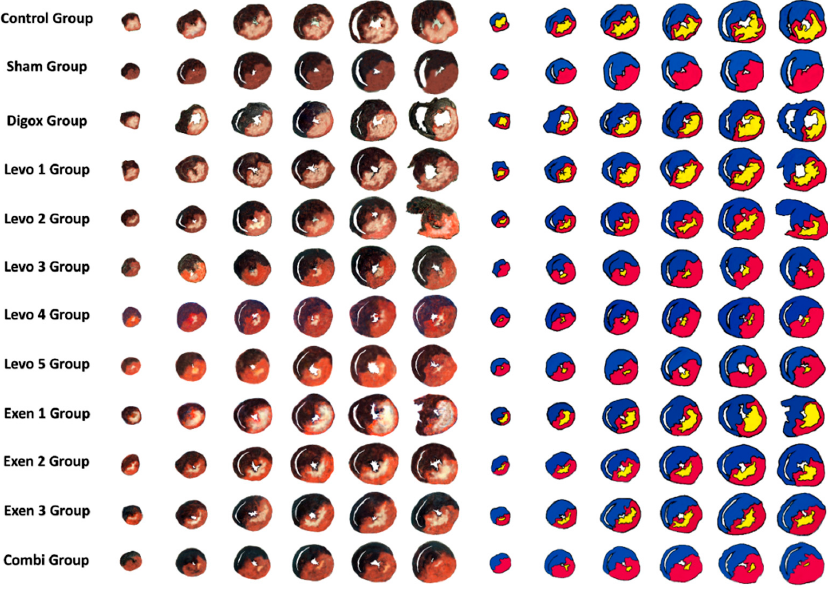
Figure 15. Sections of the hearts of all groups. A one-way ANOVA was performed to assess possible differences of Risk Area/Total Area (R/T) among groups. There was not a significant main effect of group for Risk/Total (F = 1.109, p = 0.363). (Tables 14 and 15, Figure 16). Table 14. Effect of group on R/T.